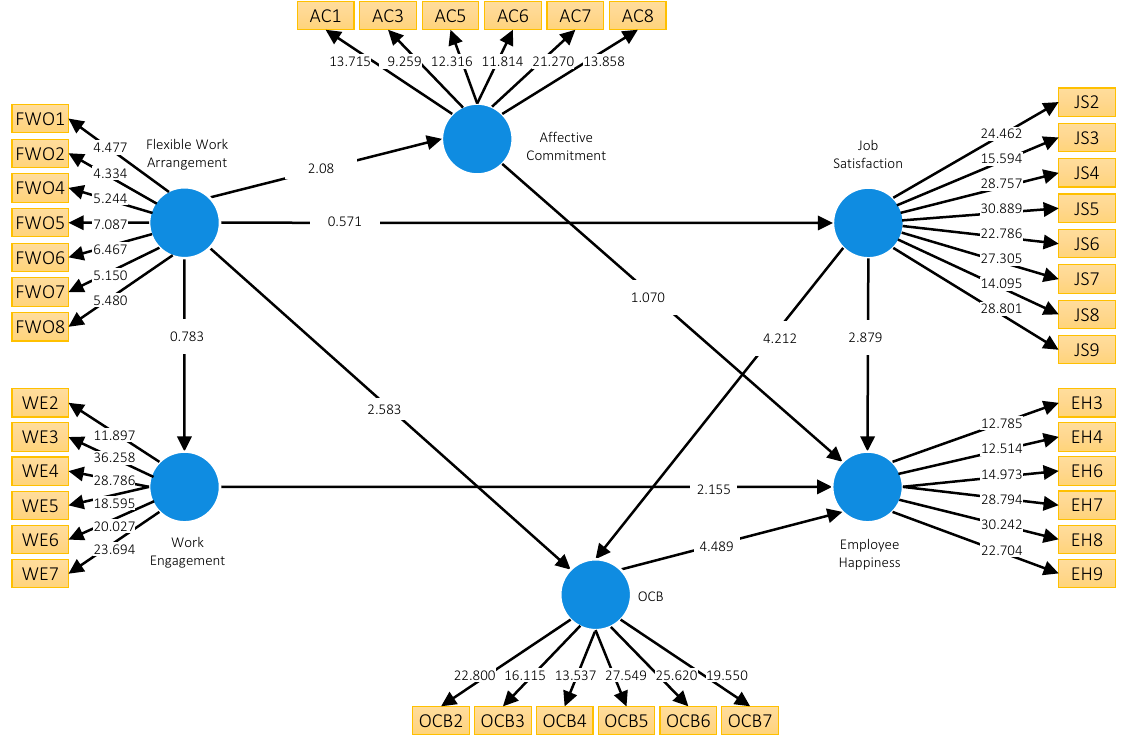
Figure 2. Structural